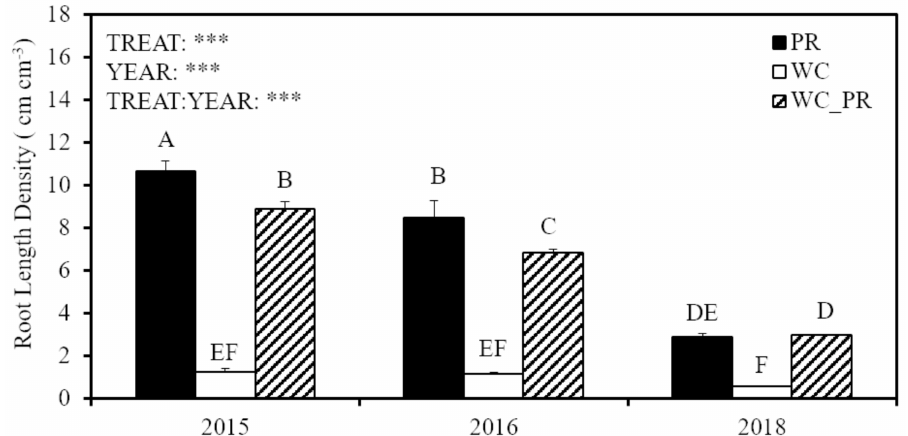
Figure 2. Root length density of 2015, 2016, and 2018 of monocultures of unfertilized perennial ryegrass (PR), white clover (WC), and white clover–ryegrass mixtures (WC_PR). Shown are means and standard errors for all eight genotypes and four replicate samplings ( n = 4). The results of the mixed models on the significance of the effect of the mixture or monoculture system (TREAT) and year (YEAR) are indicated by asterisks (*** for p ≤